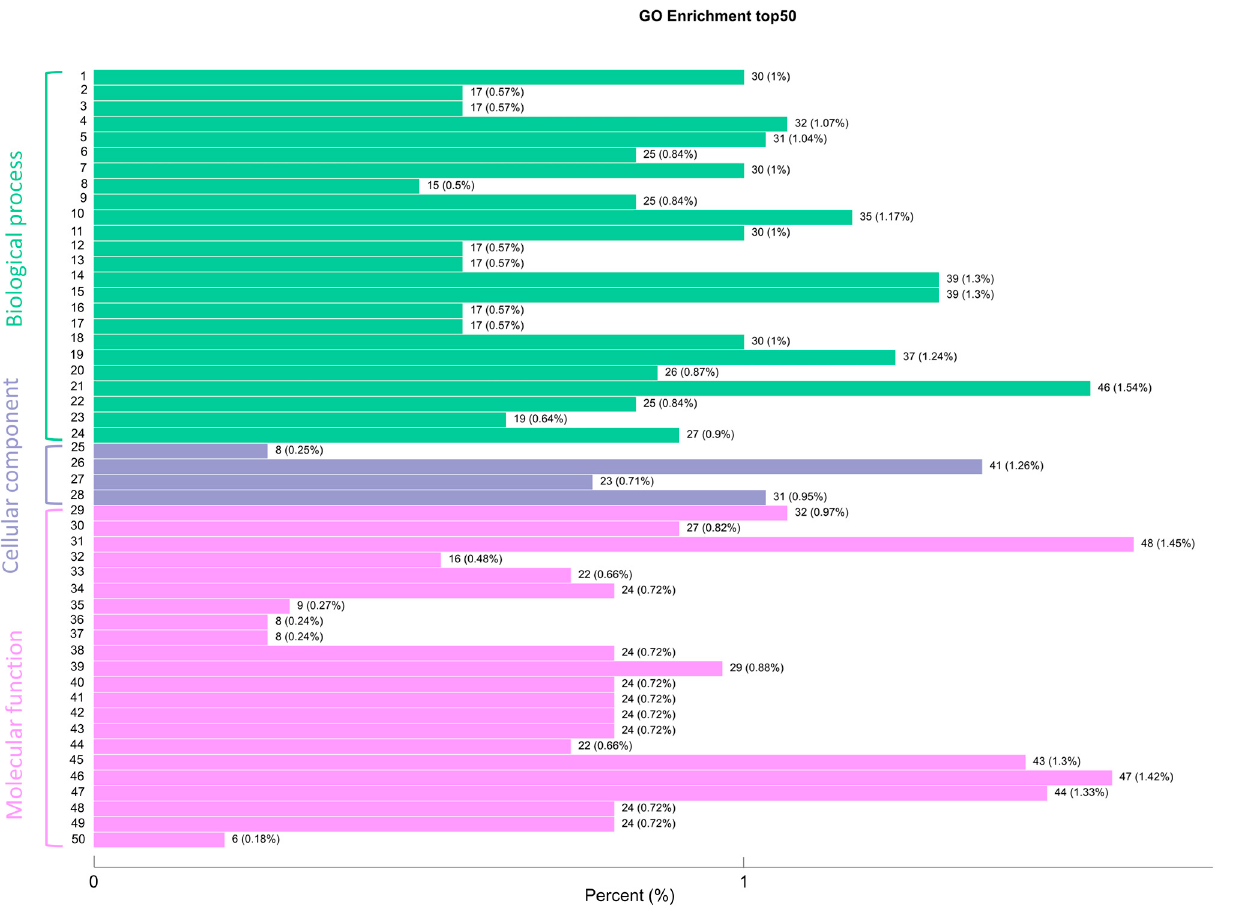
Figure 7. Gene Ontology analysis of top 50 differential expressed genes.